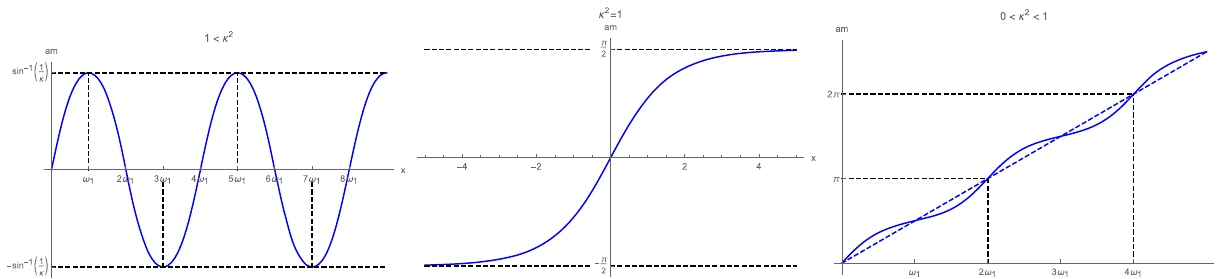
Fig. 8 The Jacobi amplitude for κ 2 = 1 . 25 (left panel), κ 2 = 1 (mid- dle panel) and κ 2 = 0 . 95 (right panel). The dashed horizontal lines on the left panel mark the extremal values of the function. These values are obtainedperiodically.Onthecontrary,onthemiddlepanel,theextremal